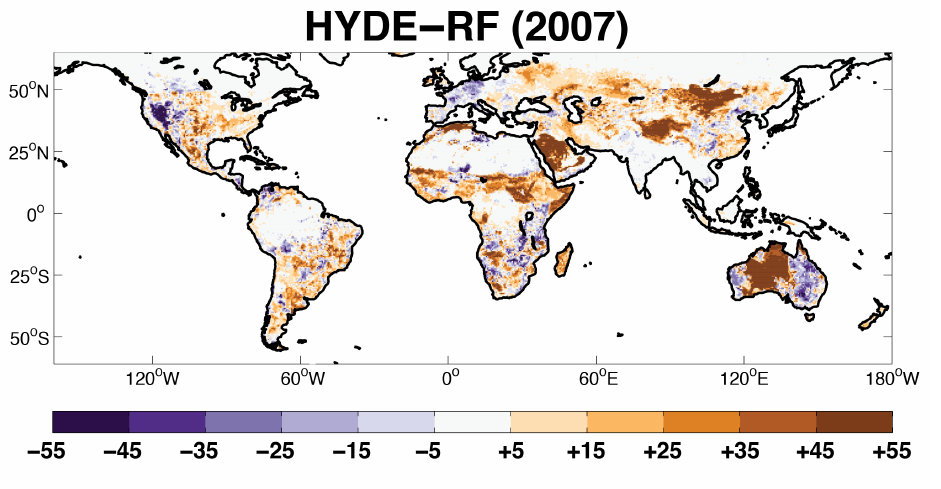
Figure 2. Difference in pasture area (percent of cell) between the HYDE and RF datasets for the latest year available from both datasets (2007). Areas in orange to red are regions where HYDE has greater pasture area than RF; purple areas are where pasture area in RF exceeds that of HYDE. Overall, HYDE indicates more widespread pasture areas than RF, especially in Asia, Africa, the Middle East, and central Australia. RF pasture area is larger in more localized areas, including western North America, Europe, and far eastern and western